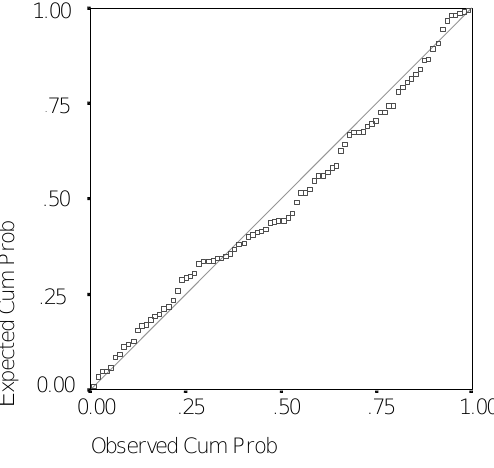
Figure 2: Normal probability (P-P) plot for unit price in PPPs